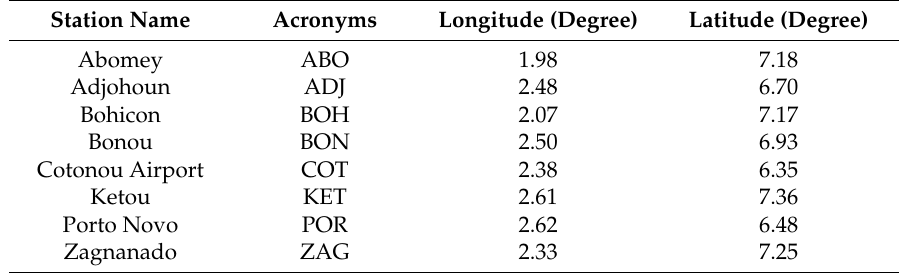
Table 1. Summary of available stations over Ou é m é Delta with latitude and